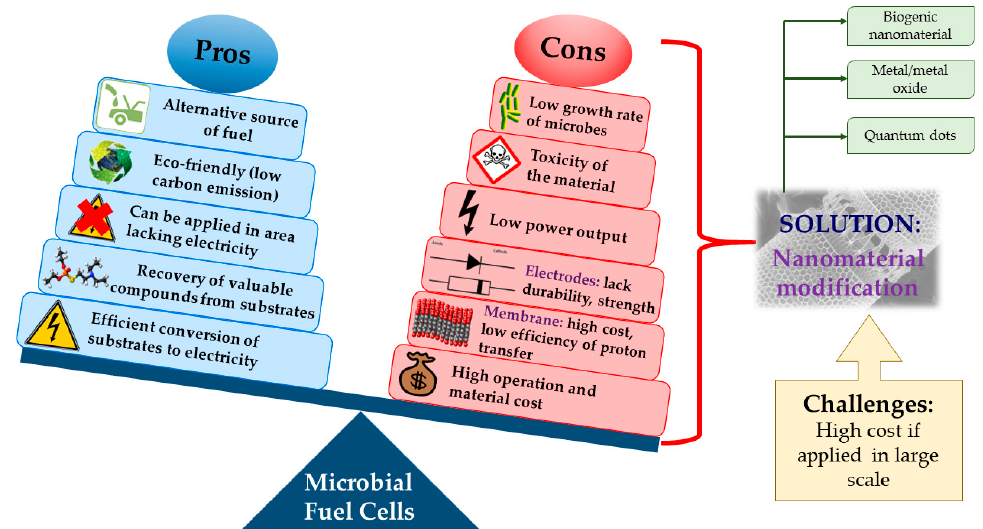
Figure 1. The component of microbial fuel cells